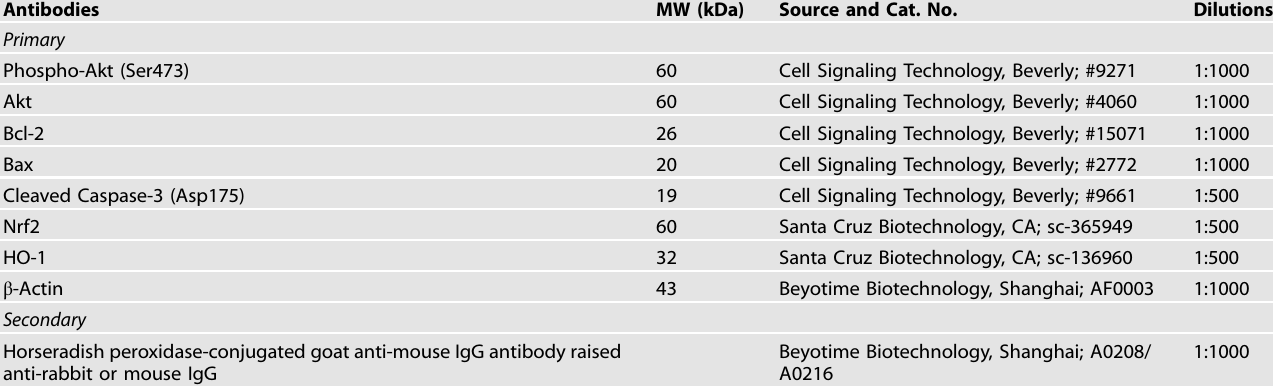
Table 1. Antibodies and dilutions used for western blotting.